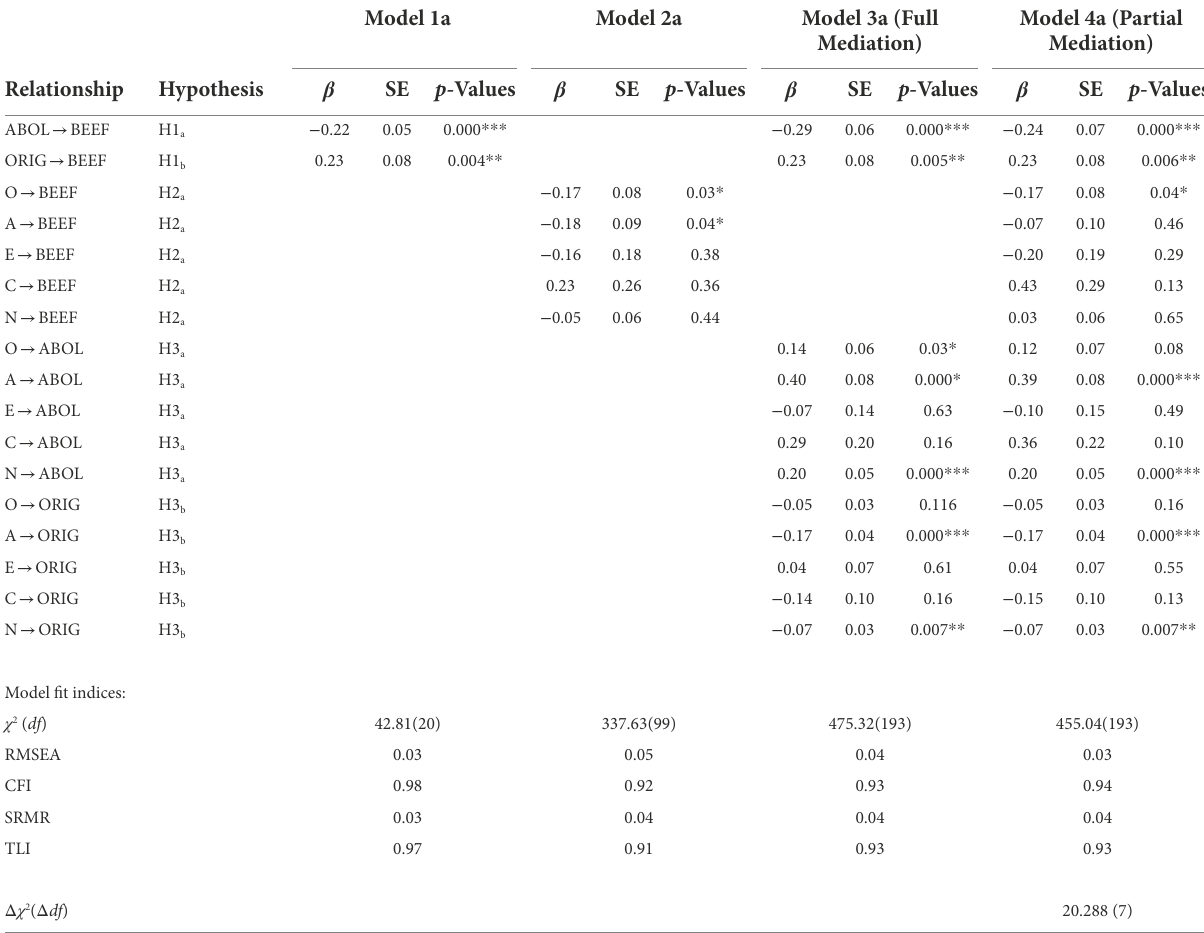
TABLE 2 Beef consumption structural equation models and fit indices, controlling for sex and parental education